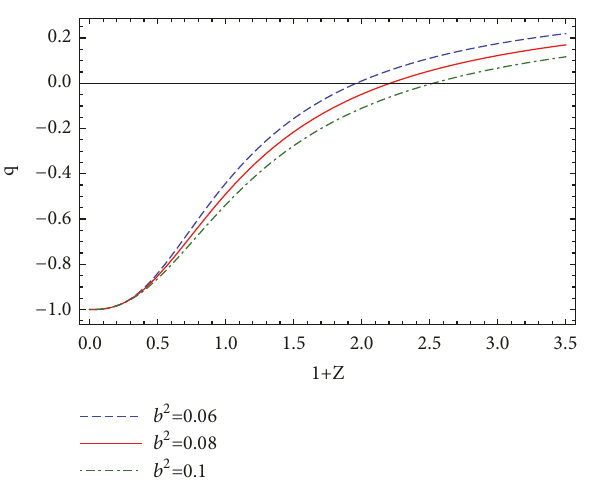
Figure 14: The evolution of the statefinder parameter 𝑟 versus the redshift parameter 𝑧 for interacting GDE in DGP model. Here, we = 0.0003. have taken Ω 𝐷 (𝑧 = 0) = 0.73 , 𝐻(𝑧 = 0) = 67 , and Ω 𝑟 𝑐